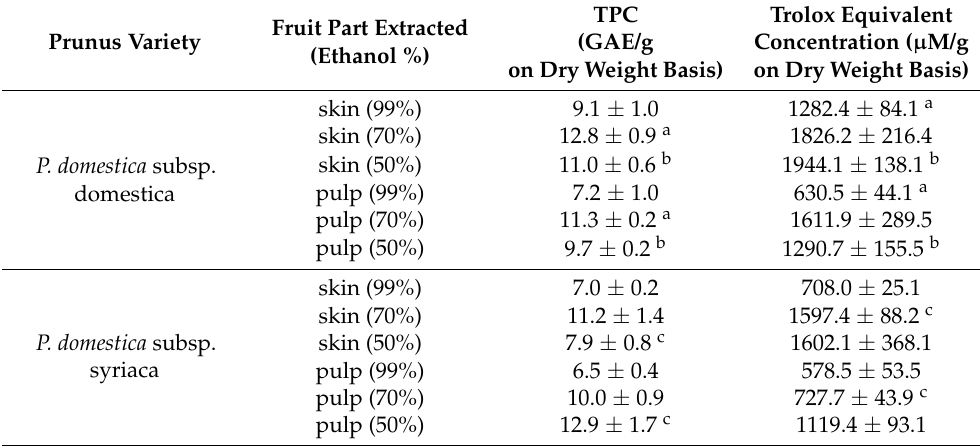
Table 2. Total phenolic content and Trolox equivalent concentration of the extracts obtained from the two varieties of P. domestica